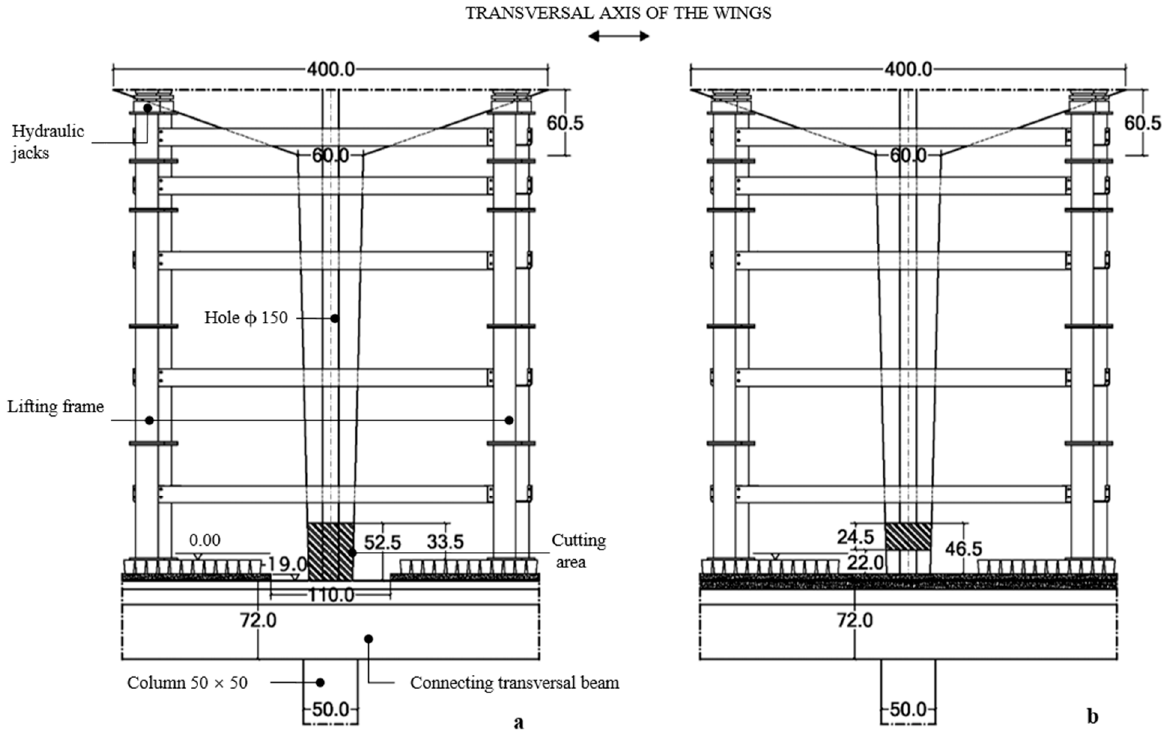
Figure 9. Placement of the steel lifting frame and the cutting zone: ( a ) for the tripod and ( b ) for the LRB device (all dimensions in cm).